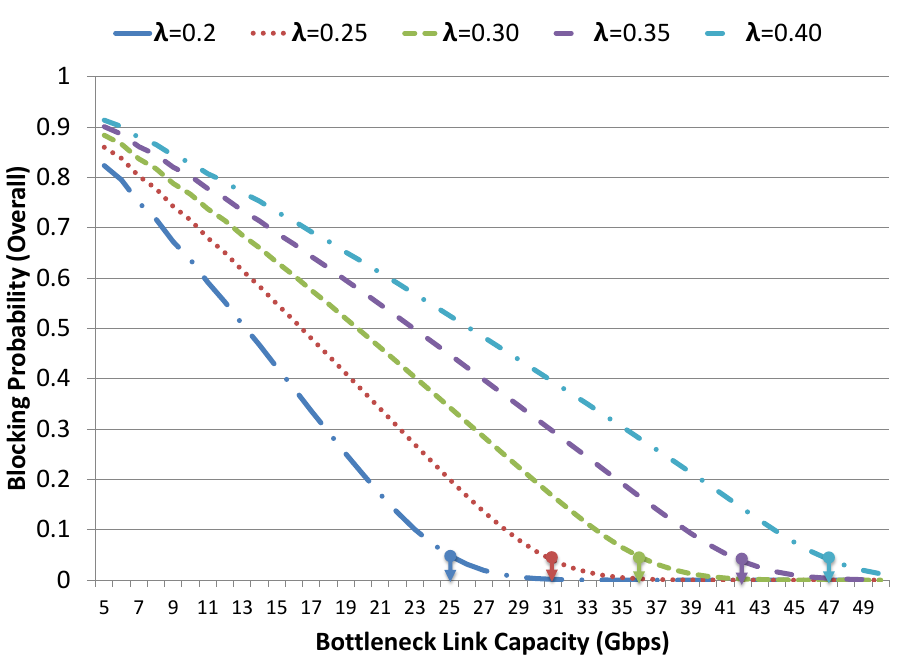
Figure 16. Network capacity planning for varying arrival rates λ = { 0.20,0.25,0.30,0.35,0.40 } and mean volume size V = 120